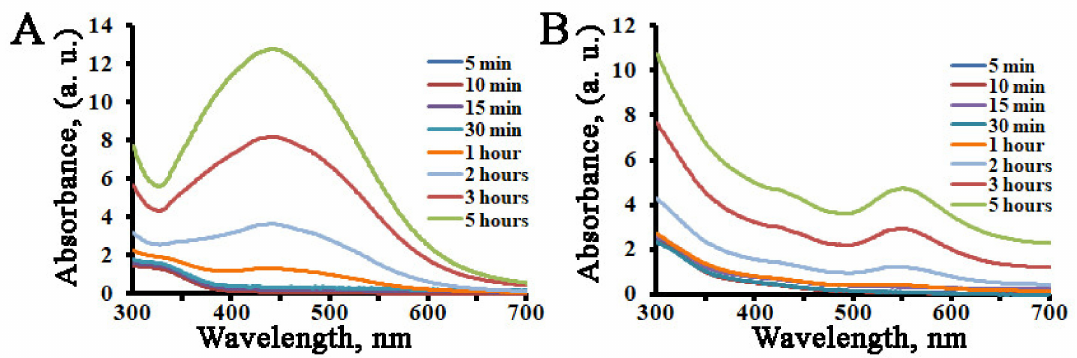
Figure 2. UV-visible spectra of AgNPs ( A ) and AuNPs ( B ) synthesized with L . erythrorhizon callus extracts as a function of reaction time.